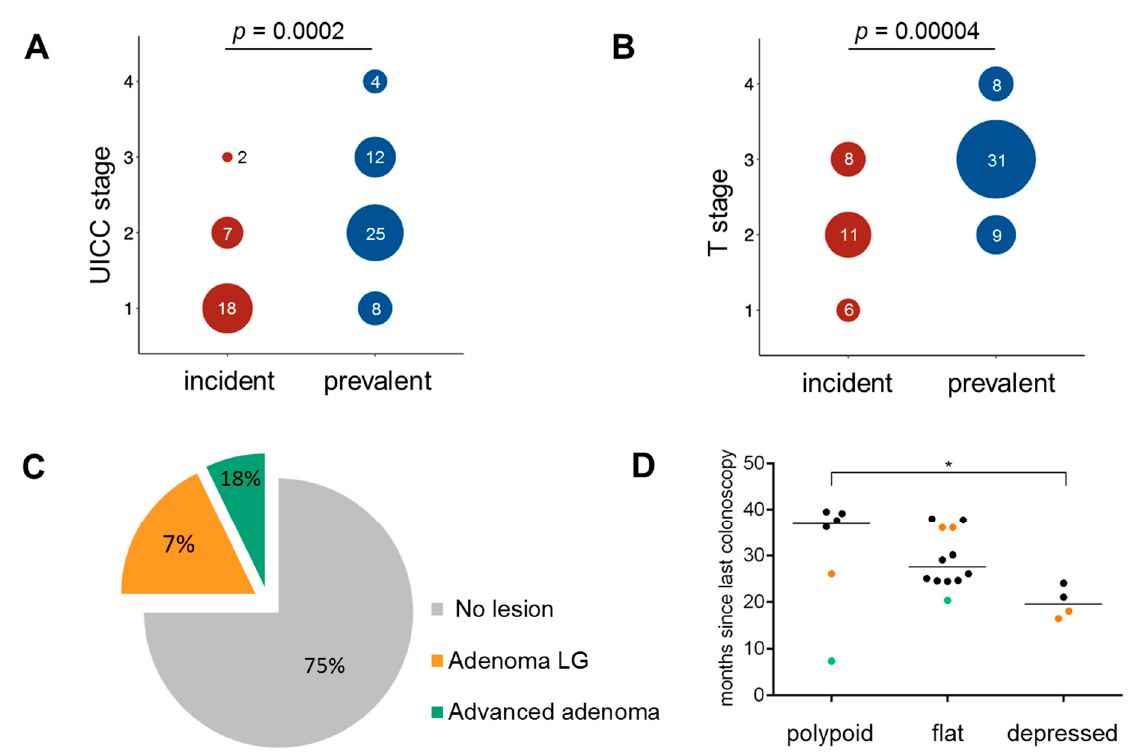
Figure 1. Clinical characteristics of incident cancers. ( A , B ) Distribution of UICC stage among incident and prevalent tumors. Tumors identified under surveillance have significantly lower UICC stage ( A ) and T stage ( B ) compared to tumors identified outside of surveillance. ( C ) Findings at previous colonoscopy in patients with incident cancers. The majority of patients with incident cancers did not present with any lesion at previous colonoscopy examination. ( D ) Association of histological growth pattern in incident cancers with time since last colonoscopy (Kruskal–Wallis test, p < 0.05 indicated by an asterisk). Green dots mark the tumors preceded by a colonoscopy identifying an advanced adenoma, orange dots mark the tumors preceded by a colonoscopy identifying an adenoma with LG dysplasia, black dots mark the tumors preceded by a colonoscopy without identification of pathological lesions. LG—low grade; UICC— Union for International Cancer Control.